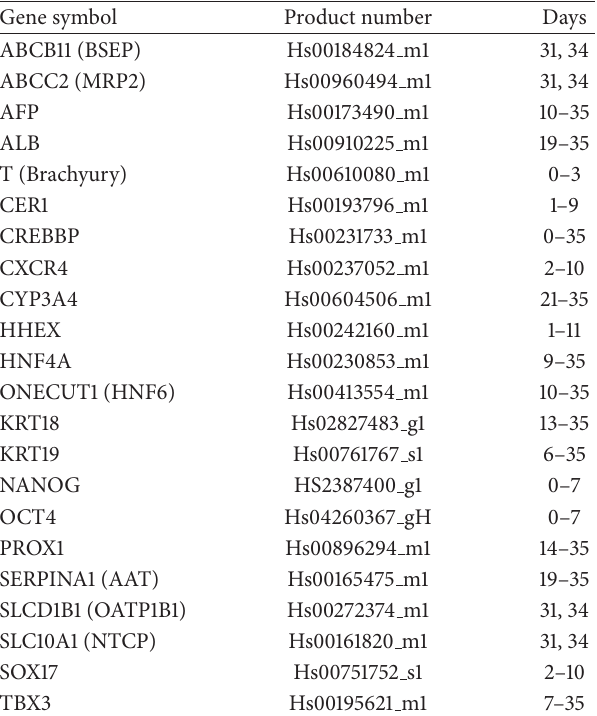
Table 1: Summary of TaqMan Gene Expression Assays used in the study and on which days of the differentiation process they were applied.